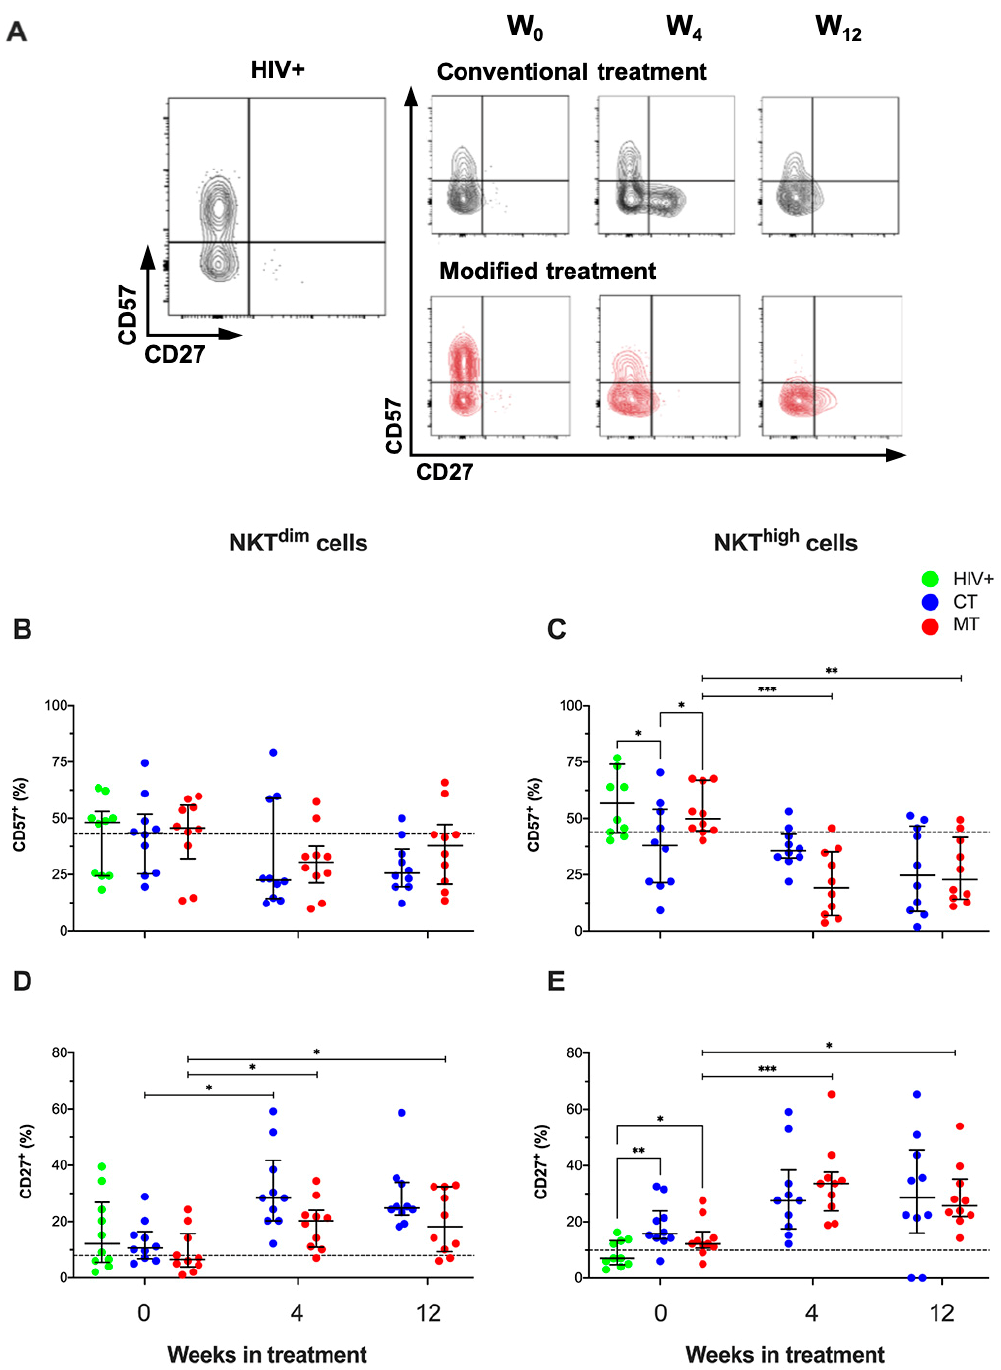
Figure 8. MT scheme decreased CD57+ NKT high cells and increased CD27+ NKTdim frequency in KS/HIV patients. ( A ) Representative density dot plots of NKT cells expressing CD57 or CD27 in HIV-negative men, HIV+, and KS/HIV patients. Frequencies of CD57+ ( B , C ) and CD27+ ( D , E ) on both NK cells subsets were evaluated across the follow-up in each group. The black dashed line represents the median value of HIV-negative men. Green dots represent HIV+ asymptomatic men, blue dots represent CT and red MT participants. Data are represented as median values and IQR. Statistical comparisons were performed using the Kruskal–Wallis test, * p < 0.05, ** p < 0.01, *** p < 0.001. Our data showed that the frequency of CD27+ NKT dim in KS/HIV patients was similar across the follow-up weeks in each group (Figure 8B). However, KS/HIV patients at W